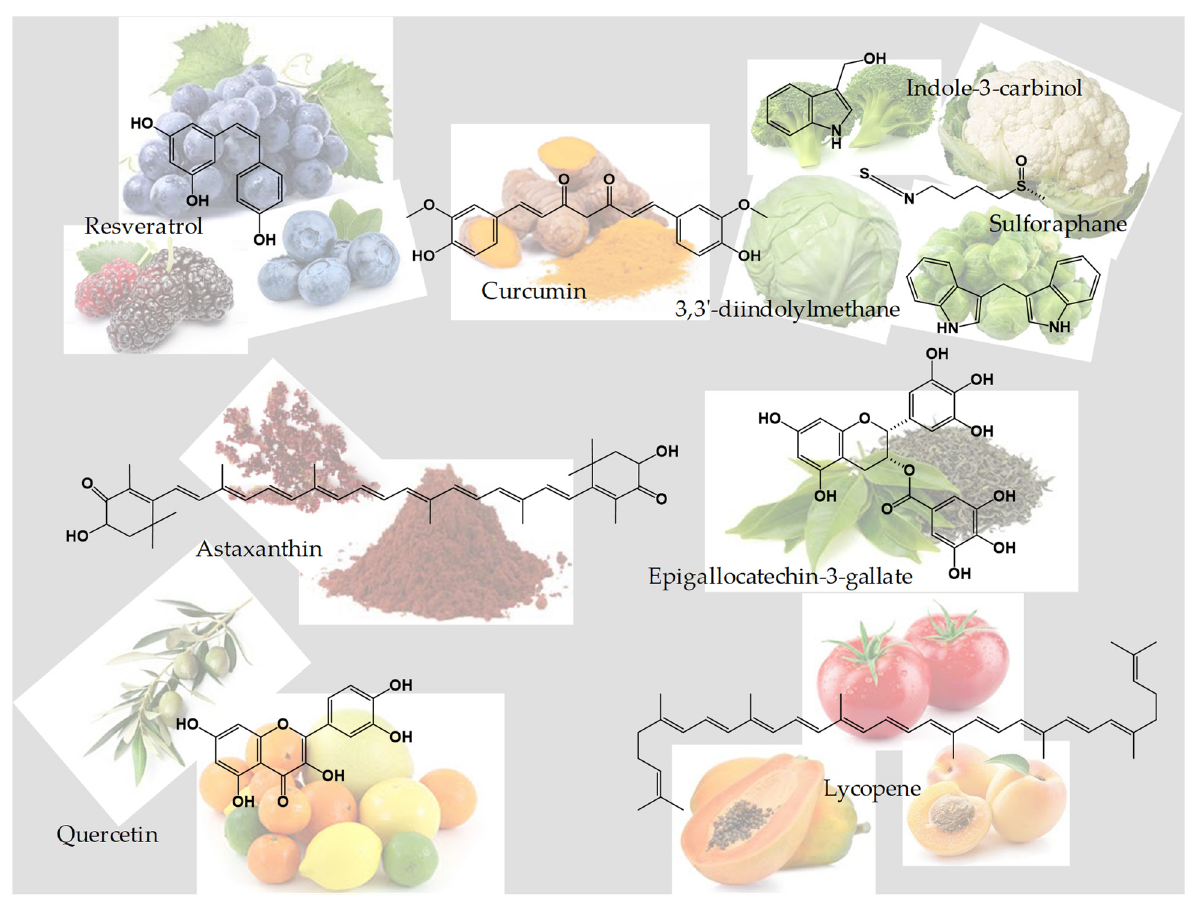
Figure 1. Main plant ‐ derived nutraceuticals. Table 2. List of plant ‐ derived bioactives currently in clinical trials on various types of cancer [76].